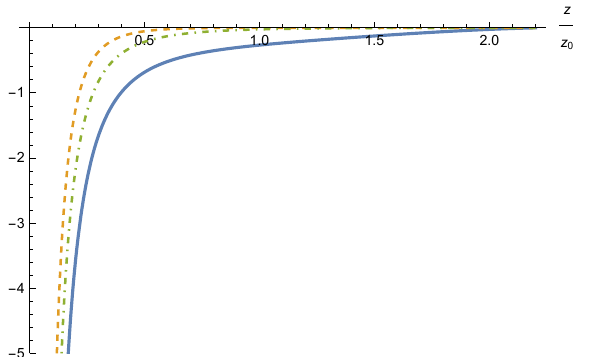
Figure 1 . The potential V + for the upper branch of E > 0 gravitino modes (blue, solid), the potential V for the lower branch of E > 0 gravitino modes (orange, dashed) and the supersymmetric − potential V (green, dash-dotted). The vertical lines are in units of 1 susy eq.